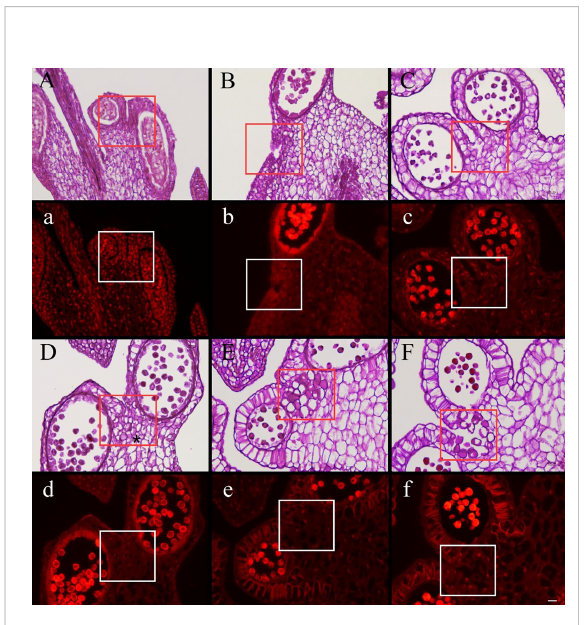
FIGURE 3 Cross section stained with periodic acid – Schiff (PAS) of Camellia oleifera anthers during the development stages of pseudopollen under light microscope (A – F) and fl uorescence microscope (a – f) . (A, B) The cells of connective are undifferentiated. (a, b) Polysaccharides show a red reaction under the fl uorescence of connective cells. (C) The parenchyma cells gradually begin to form free ellipsoid cells. (D) Adjacent cells are pressed to form a boundary (*). (E) The pseudopollen grains are fully expanded. (F) The pseudopollen grains separate from each other. (c – f) In the process of pseudopollen development, the pseudopollen grains are almost completely black under fl uorescence. The red and white rectangle represents the site where the pseudopollen is produced. Bar = 100 m m.